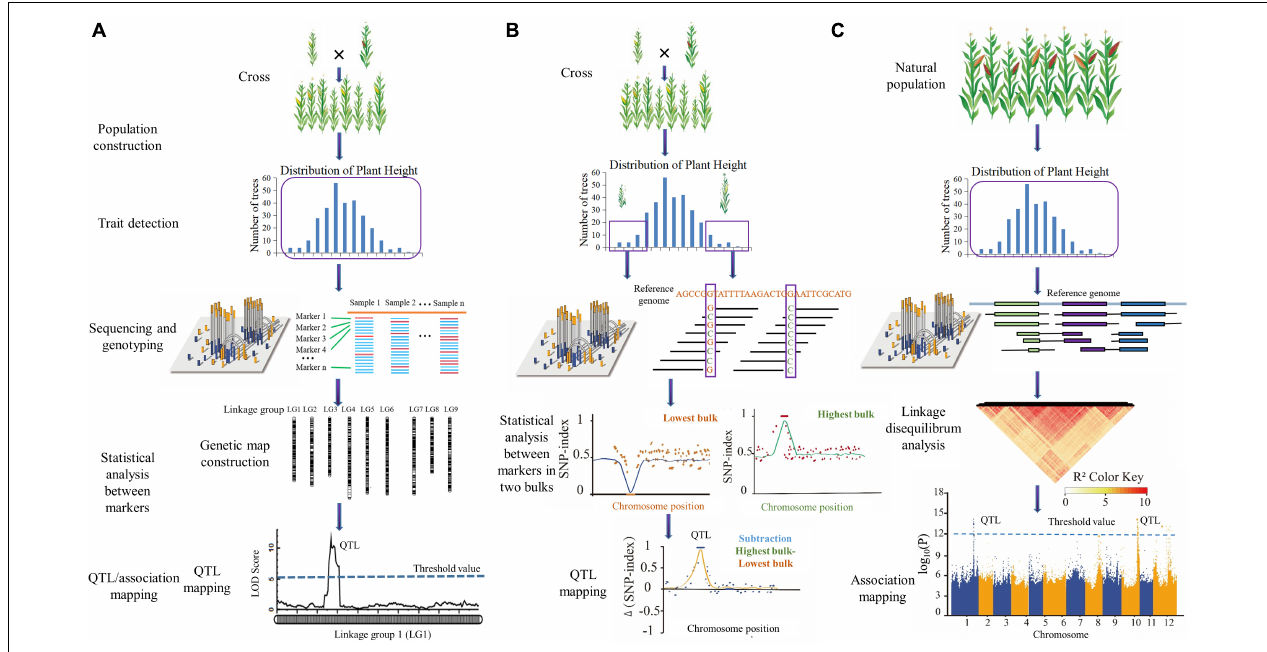
FIGURE 1 | The procedure of MAS combining next-generation sequencing (NGS). (A) Linkage mapping; (B) bulk segregation analysis (BSA); (C) association mapping. Genetic population construction, morphological trait detection, population sequencing and genotyping, statistical analysis between markers, and QTL/association mapping are common procedures in MAS combining